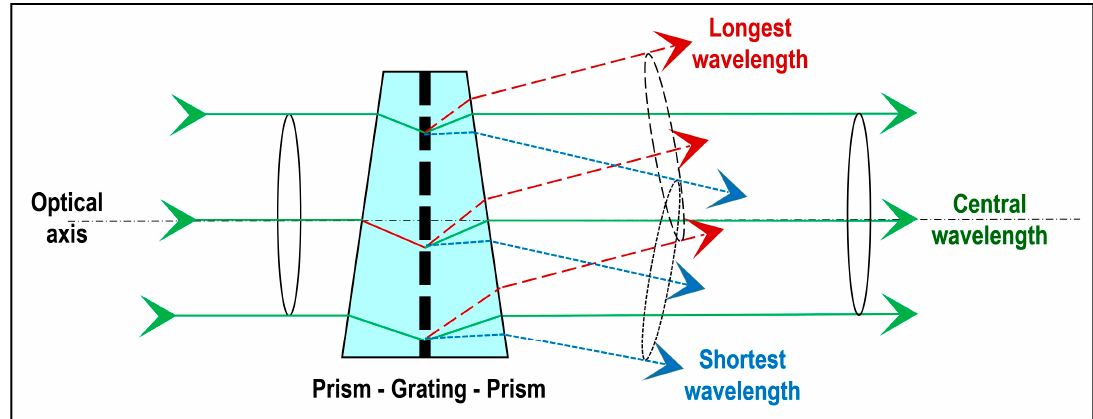
Figure 2. Basic principle of the direct-vision PGP element.